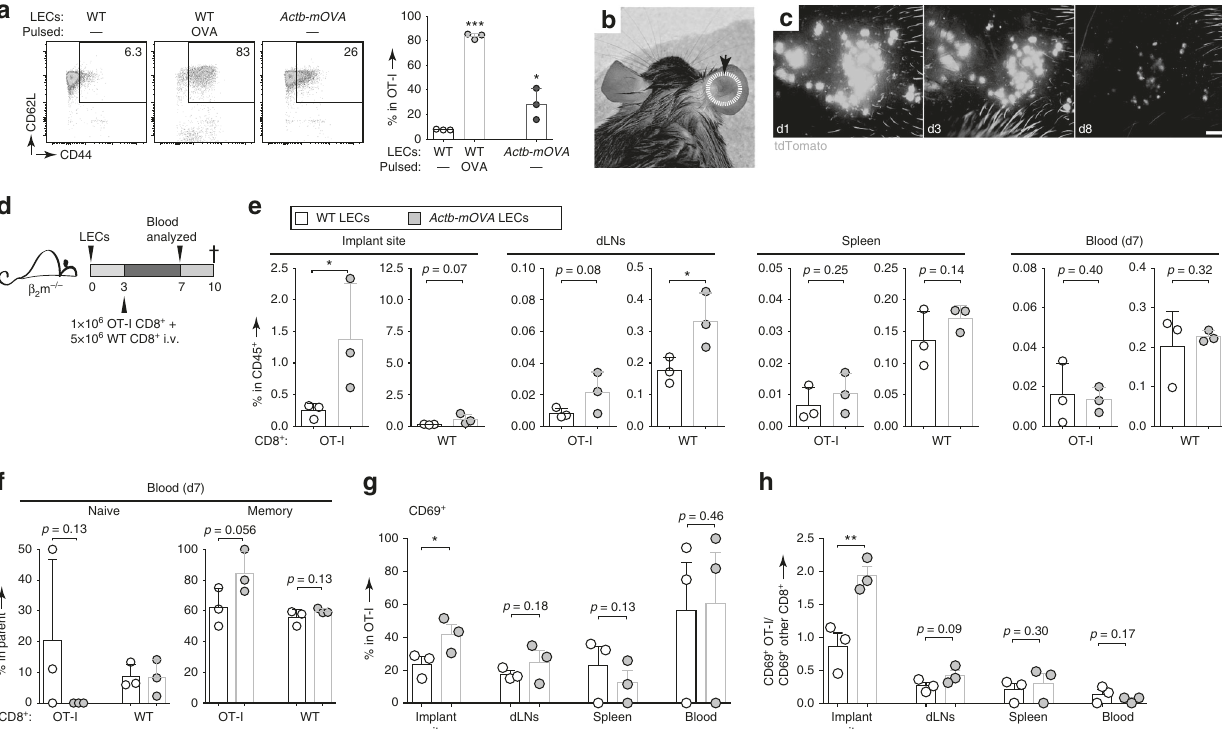
Fig. 3 LECs induce memory phenotype in cognate CD8 + T cells in vivo. a Memory phenotype of OT-I cells after 3 day co-culture with resting or OVA- pulsed WT primary LN-LECs compared to resting LN-LECs from constitutively OVA-expressing ( Actb-mOVA ) mice (left, representative fl ow cytometry plots; right, percentages of live OT-I cells with a memory phenotype (CD44 + CD62L + ). b Photograph of a mouse that received LEC spheroids in one ear. The implant site is clearly visible for weeks post-implantation due to in fl ammation (dotted circle). c Fluorescent LEC spheroids processed from ProxTom mice after implantation into WT C57Bl/6 mice (scale = 500 μ m). d Experimental schedule for e – h . LECs from WT vs. Actb-mOVA mice were processed into spheroids and then implanted into one ear of β 2 m − / − recipients, which later received 1:5 ratio of cognate (OT-I):bystander (WT) CD8 + T cells via the tail vein. Blood (d7) and other organs of interest (d10) were harvested for analysis by fl ow cytometry. e Frequency of OT-I vs. WT CD8 + T cells among live immune cells in all organs assayed. Y -axes scales were adjusted to account for the starting ratio of OT-I:WT CD8 + T cells. f Quanti fi cation of percentage of circulating OT-I and bystander CD8 + T cells that exhibit naïve (CD44 − CD62L + ) versus memory (CD44 + CD62L + ) phenotype. g Frequency of live OT-I cells that expressed CD69 at all organs assayed. h Ratio of activated OT-I cells to activated bystander CD8 + T cells, based on CD69 expression at all organs assayed. Columns and error bars indicate mean ± SD a , e , f or SEM g , h for n = 3 from one representative of two independent